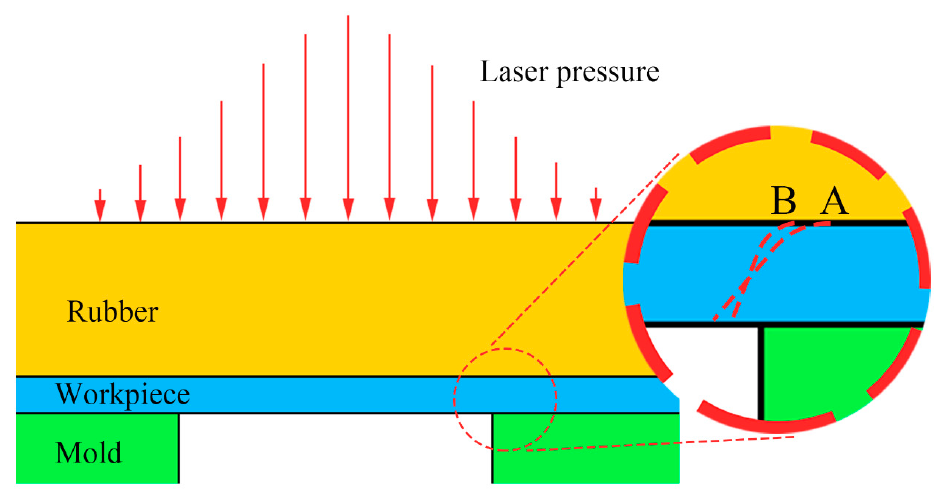
Figure 22. Force acting before laser dynamic flexible micropunching.